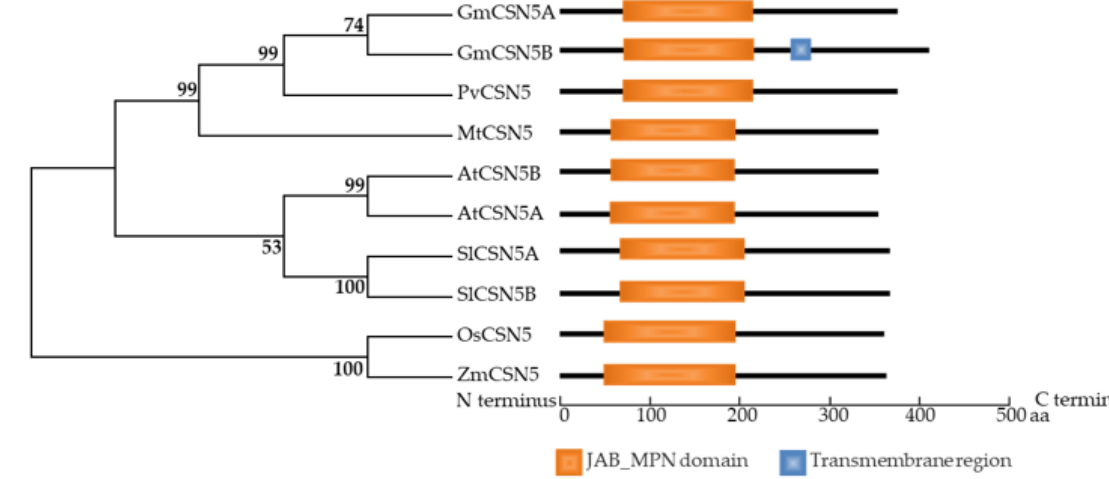
Figure 3. Phylogenetic analysis of CSN5s in plant. The phylogenetic tree was generated ground on an amino acid alignment of CSN5 proteins from well-known species using the Mega 5.05 program. The gene loci on the Phytozome website are as follows: AtCSN5A (At1G22920), AtCSN5B (At1G71230), GmCSN5A (Glyma.04G075000), GmCSN5B (Glyma.06G076000), PvCSN5 (Phvul.009G100700), MtCSN5 (Medtr3g108790), SlCSN5A (Solyc06g073150), SlCSN5B (Solyc11g017300), OsCSN5 (LOC_Os04g56070), ZmCSN5 (GRMZM2G086801). At, Arabidopsis thaliana ; Gm, Glycine max ; Os, Oryza sativa ; Pv, Phaseolus vulgaris ; Zm, Zea mays ; Mt, Medicago truncatula ; Sl, Solanum lycopersicum .